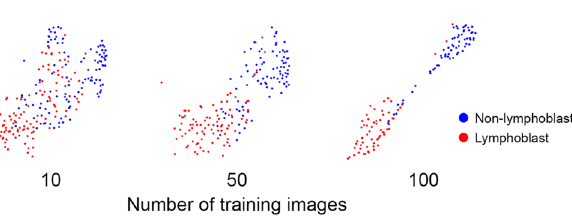
Figure 5. Separation of binary classes increases with increasing number of training images. tSNE reduces the 32 dimensions of the last hidden layer of networks trained with 10, 50, and 100 images to two dimensions. Coloring the last hidden layer for the respective 215, 175 and 125 lymphoblast and non-lymphoblast images shows an increasing cluster separation of the two classes with increasing training set size even though the ROC- AUCs for 50 or 100 training images are similar (see Fig. 2A).